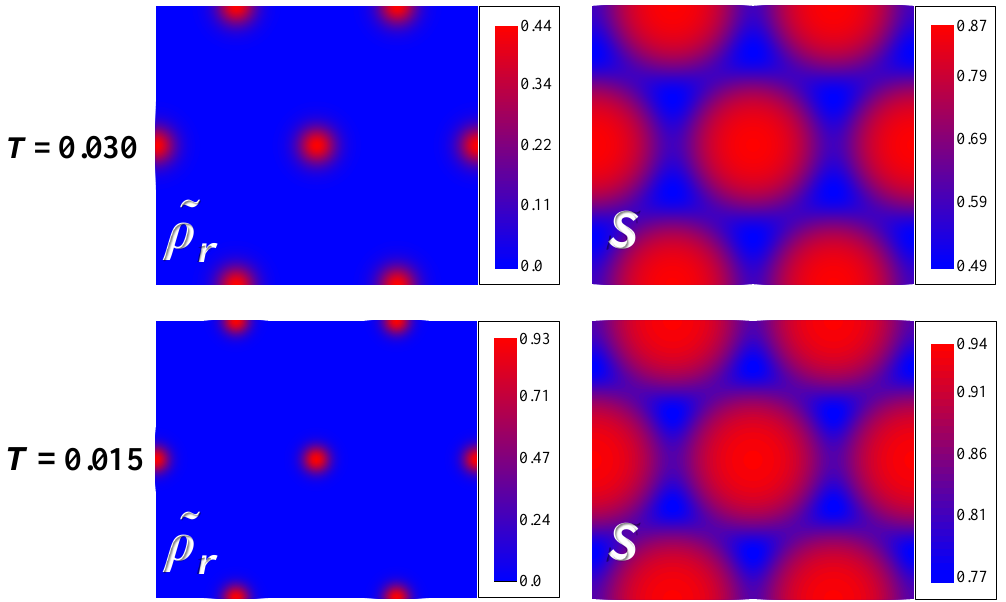
Figure 3. Spatial distributions of the reduced density ˜ ρ r and the nematic order parameter S of the rod-like fragments of copolymer molecules in the hexagonal phase calculated numerically for f c = 0.85 and for two different temperatures T = 0.03 and T = 0.015 indicated by the gray arrows in Figure